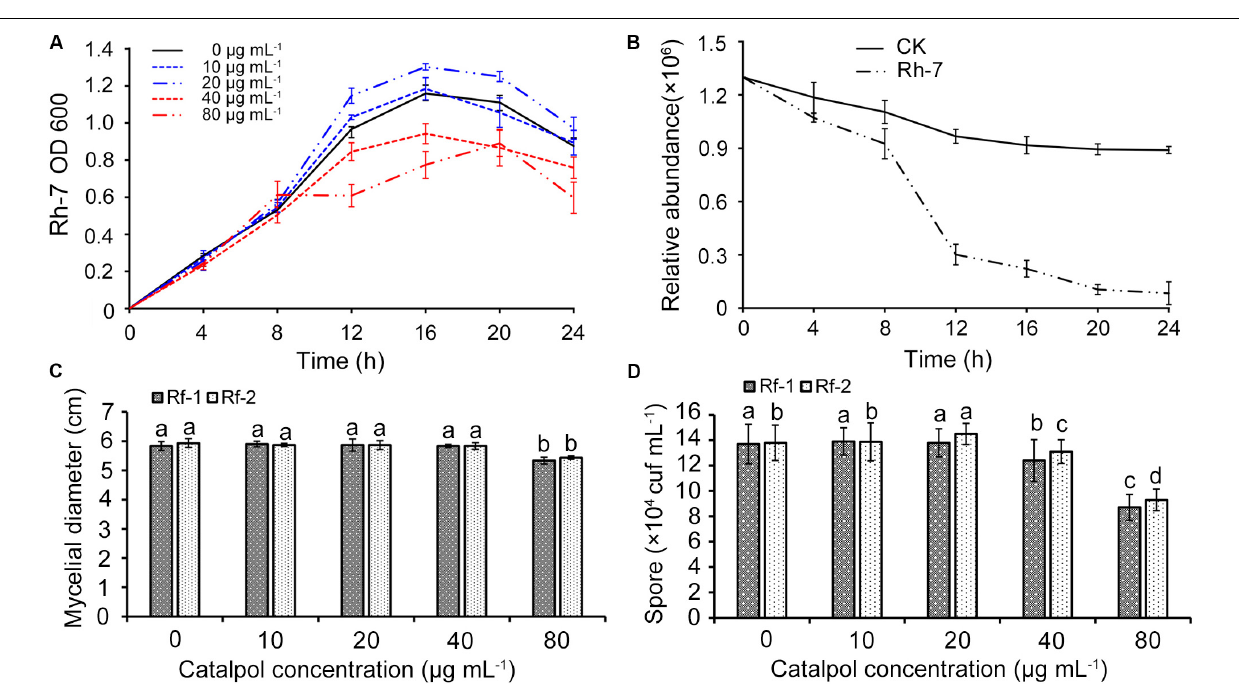
FIGURE 14 | Effects of key R. glutinosa root exudate (catalpol) on growth of strain Rh7, Rf1, and Rf2. (A) Growth curves of strain Rh7 under different dosages of catalpol. (B) Quantification of catalpol in the cultures (20 µ g mL − 1 ) incubated with and without Rh7. (C) Mycelial diameter of strain Rf1 and Rf2 in the plates containing different dosages of catalpol. (D) Spores of strain Rf1 and Rf2 in the plates containing different dosages of catalpol. Different letters indicate statistical difference ( p <